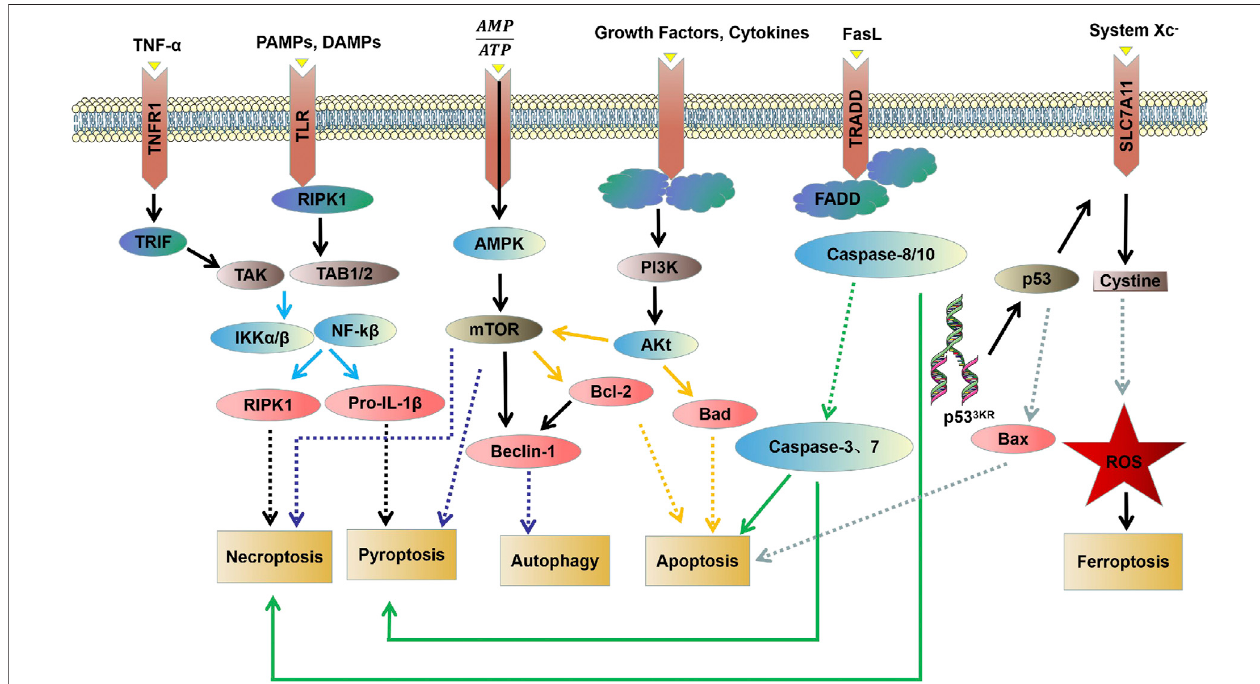
FIGURE 2 | The interrelationship between different PCD molecular